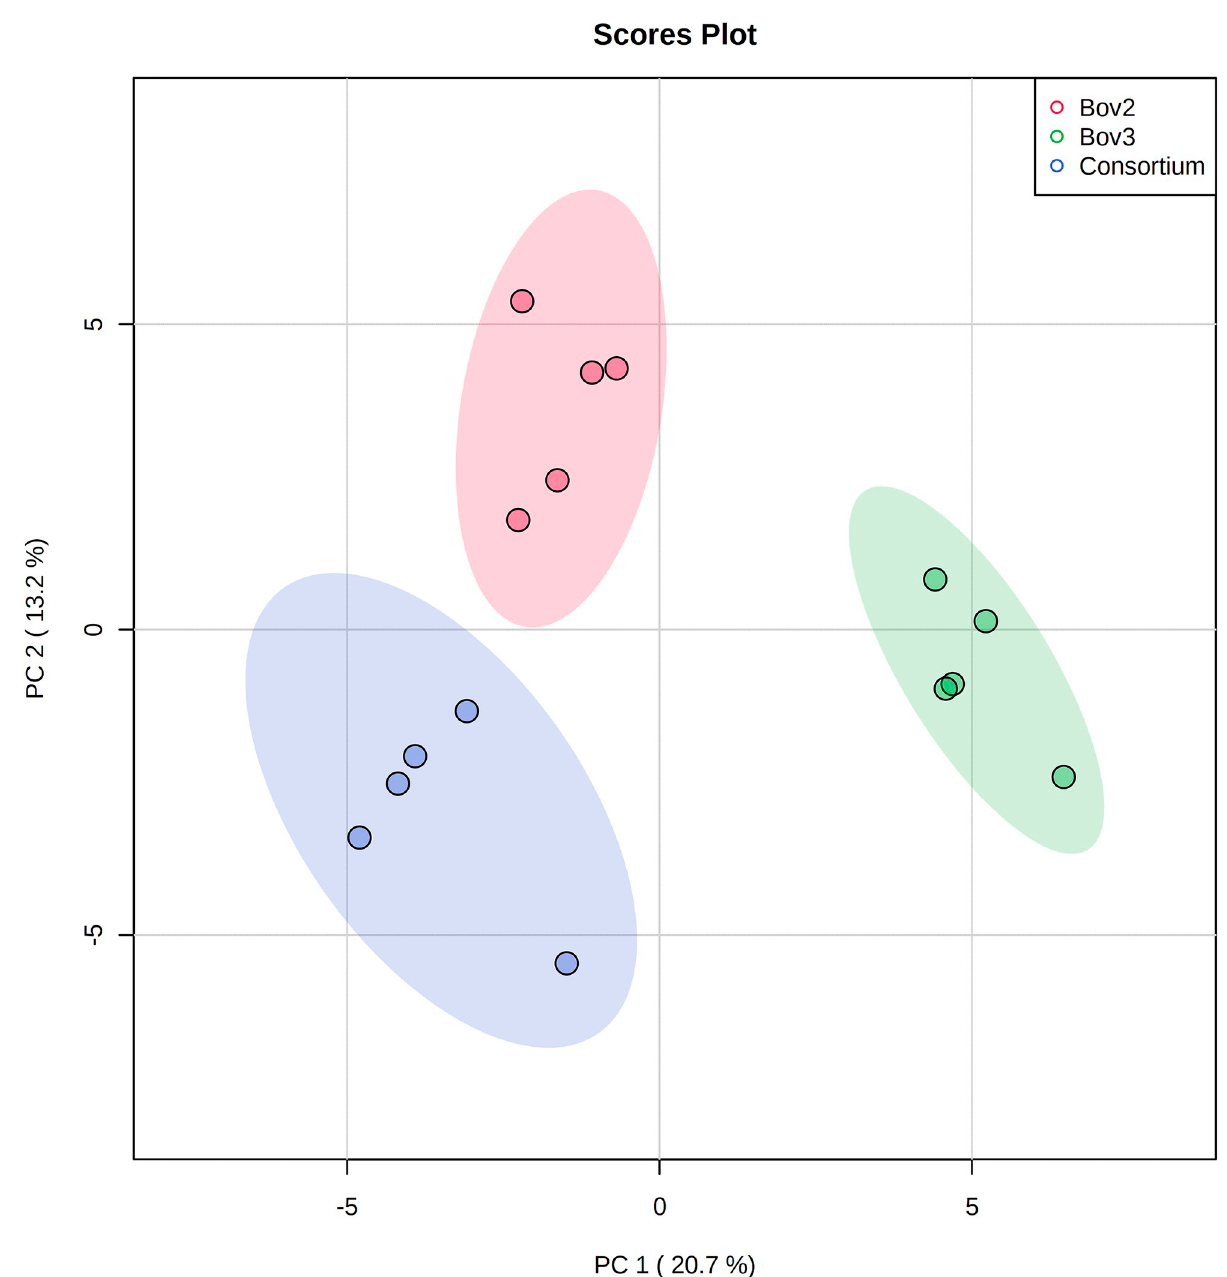
Fig 1. 2-D SCORE PLOT of the metabolites identified in Bov 2, Bov 3 and consortium by